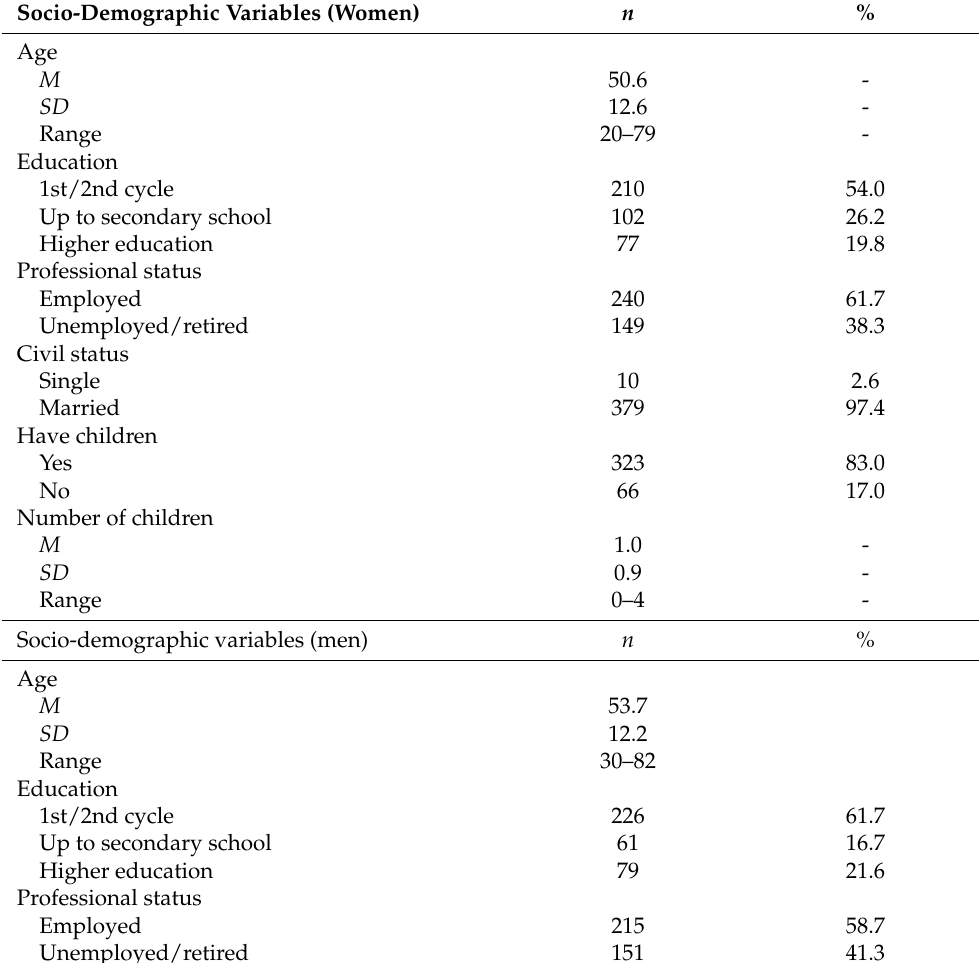
Table 1. Sociodemographic, clinical, relationship and therapeutic involvement, psychological comor- bidity, and body image